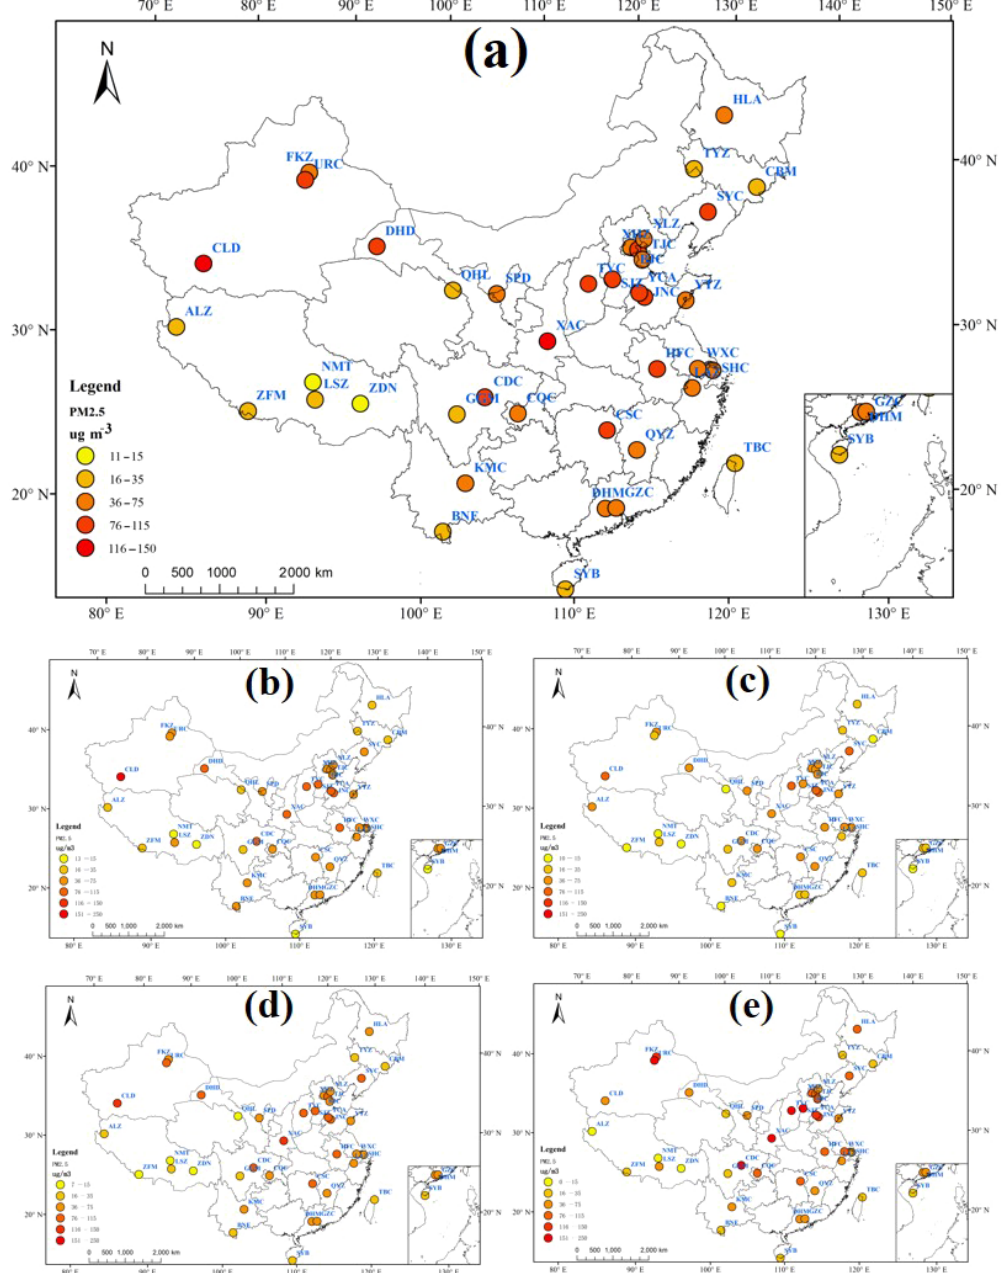
Figure 1. Locations and the averaged PM 2 . 5 concentrations of the 40 monitoring stations during (a) 2012–2014, (b) spring, (c) summer, (d) autumn and (e) winter. The site codes related to the observation stations can be found in Table